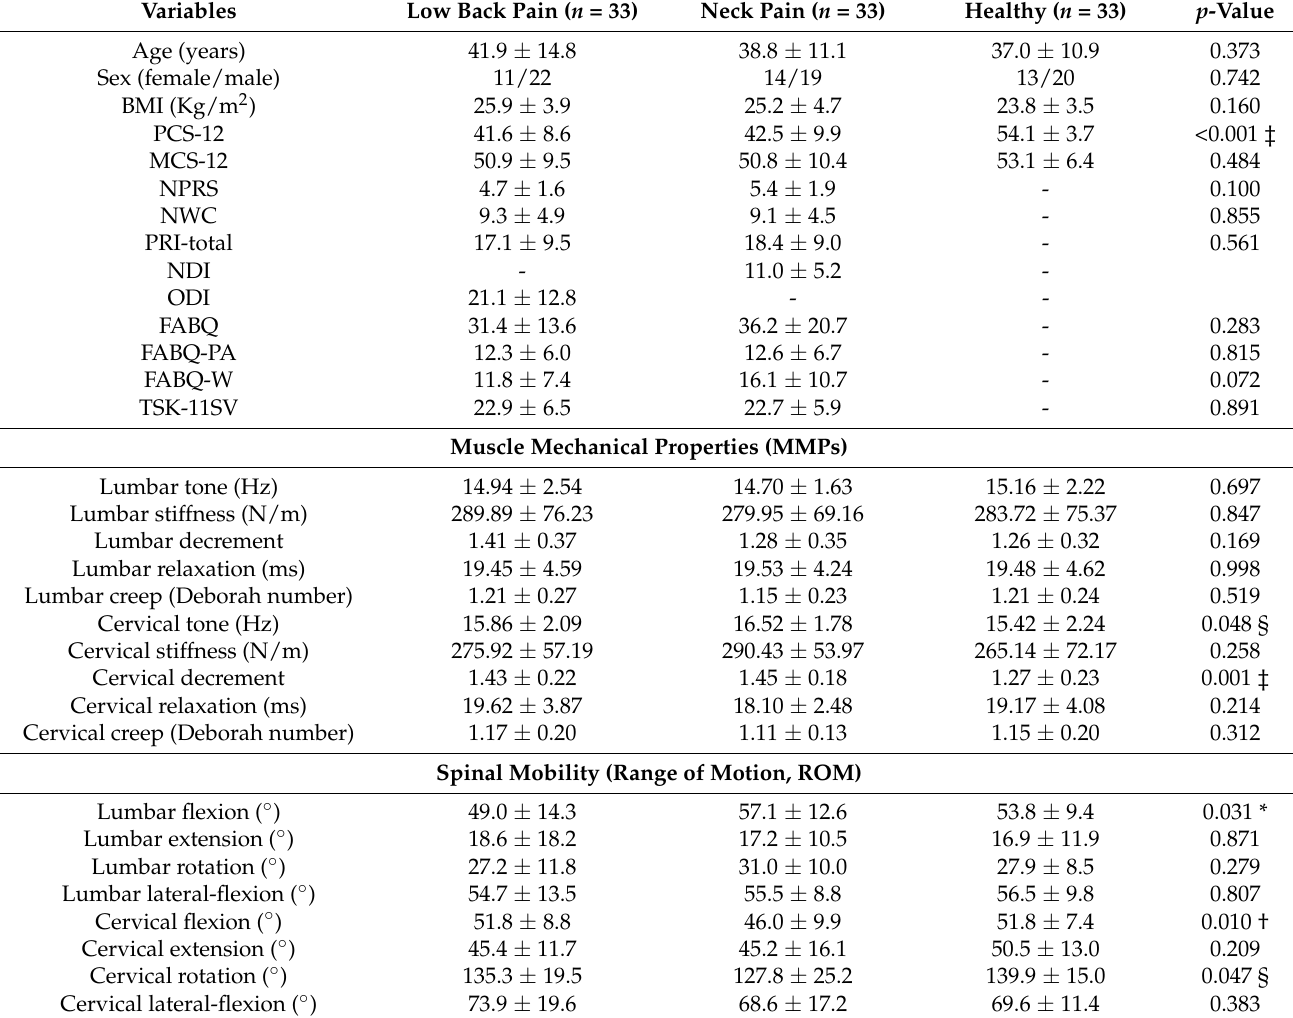
Table 1. Sociodemographic and clinical characteristics of patients with acute low back pain, acute neck pain and healthy